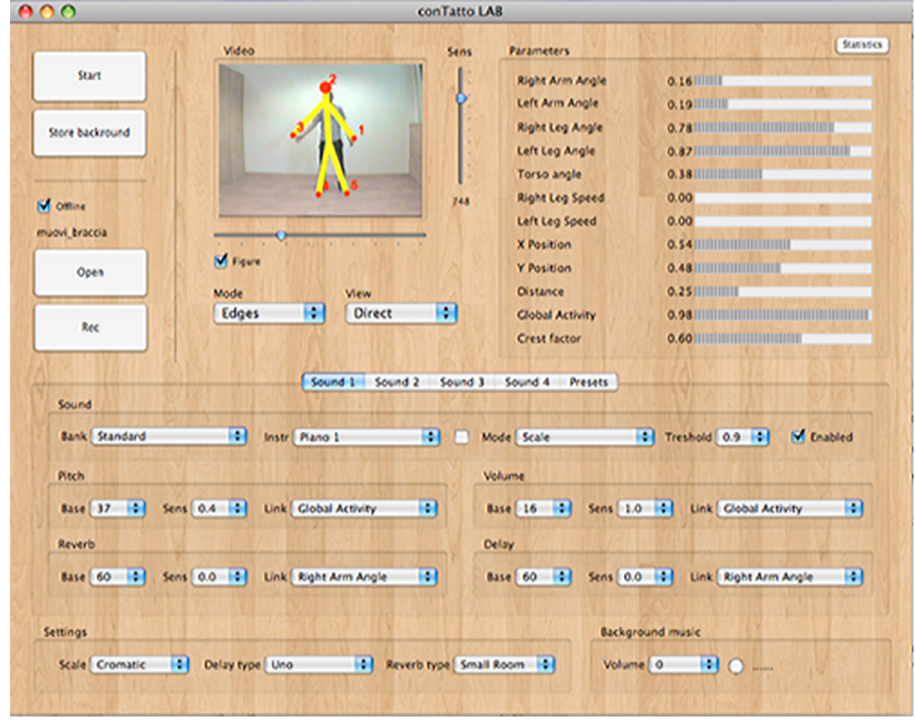
Figure 1. GUI of the SIREMI software.